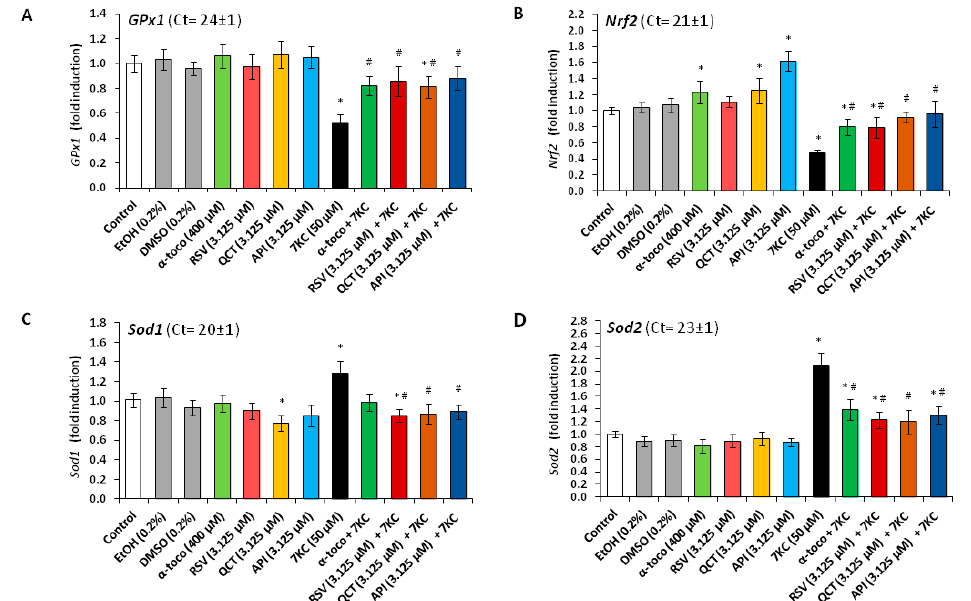
Figure 4. Effect of resveratrol, quercetin, apigenin or α -tocopherol on 7KC-induced oxidative stress: measurement of GPx1 , Nrf2 , Sod1 and Sod2 mRNA levels by real time-quantitative polymerase chain reaction. N2a cells were cultured for 48 h with or without 7-ketocholesterol (7KC, 50 µM) in the presence or absence of α -tocopherol ( α -toco: 400 µM) used as a positive control for cytoprotection, or with polyphenols: resveratrol (RSV), quercetin (QCT) or apigenin (API) used at a concentration of 3.125 µM. The relative expression of GPx1 ( A ), Nrf2 ( B ), Sod1 ( C ) and Sod2 ( D ) mRNAs was determined by real time-quantitative polymerase chain reaction (RT-qPCR). In untreated cells, the cycle threshold (Ct) values are provided for each gene studied: GPx1 (Ct = 24 ± 1), Nrf2 (Ct = 21 ± 1), Sod1 (Ct = 20 ± 1) and Sod2 (Ct = 23 ± 1). Data shown are mean ± standard deviation (SD) of two independent experiments conducted in triplicate. Significance of the differences between control (untreated cells) and RSV-, QCT-, API-, α -toco- or 7KC-treated cells; Mann–Whitney test: * p < 0.05 or less. Significance of the differences between 7KC-treated cells and (7KC + (RSV, QCT, API or α -toco))-treated cells; Mann–Whitney test: # p < 0.05 or less. No significant differences were found between control and vehicle-treated cells (Ethanol (EtOH): 0.2% and DMSO: